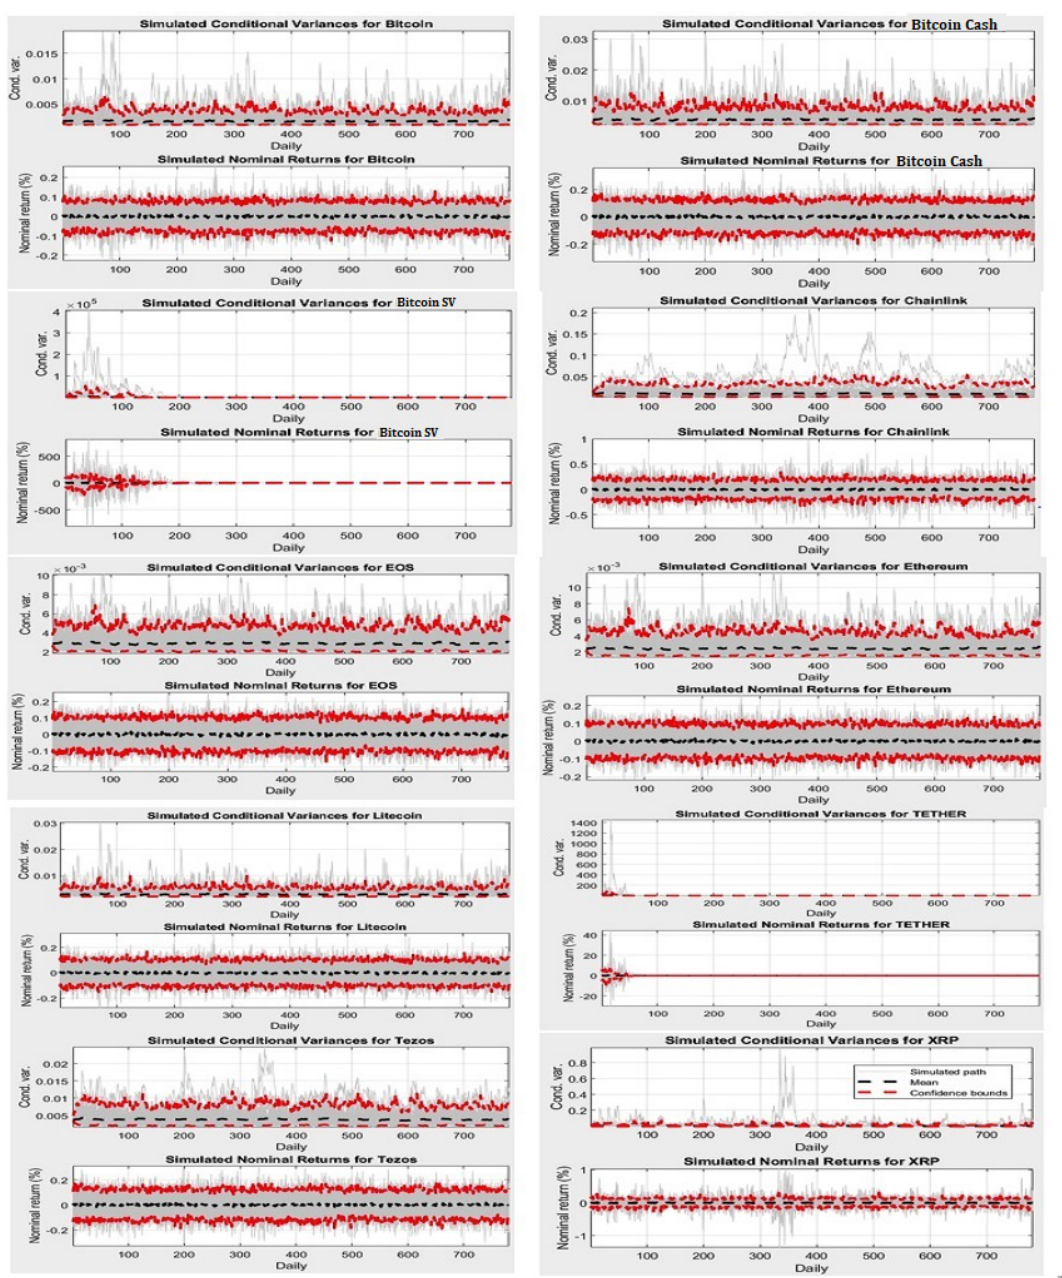
and Figure 7. Our results show that Bitcoin, Bitcoin Cash, Etherium, and Litecoin suffer the most from tail-risk whereas TETHER has the least tail-risk.